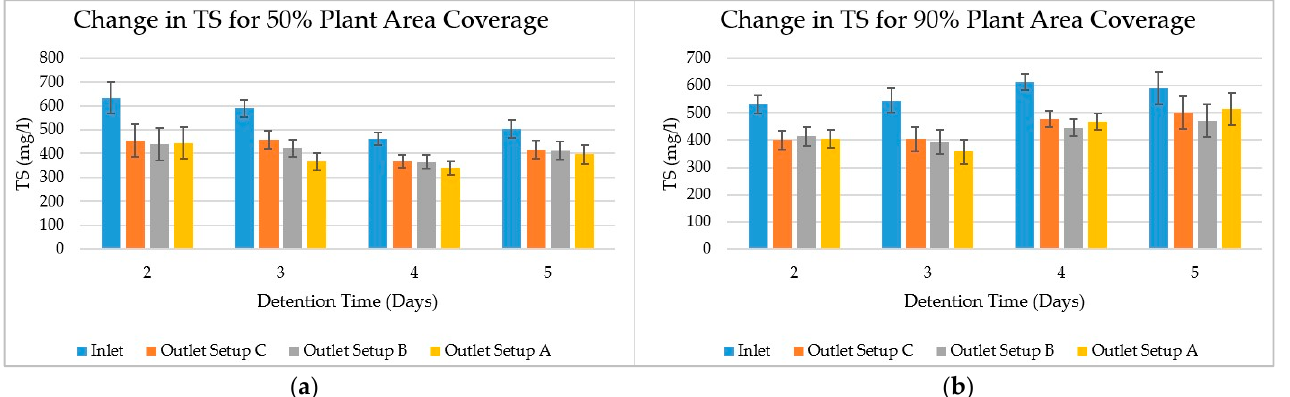
Figure 7. Change in TS with respect to Detention Time: ( a ) Change in TS for 50% plant area coverage; ( b ) Change in TS for 90% plant area coverage .